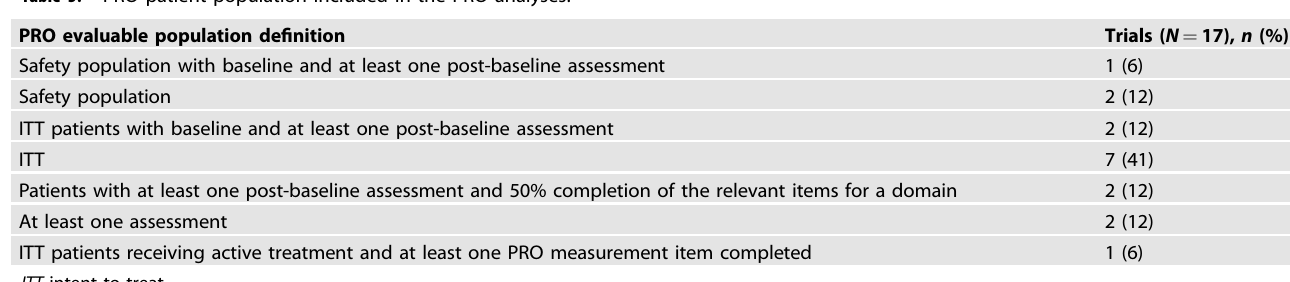
Table 3. PRO patient population included in the PRO